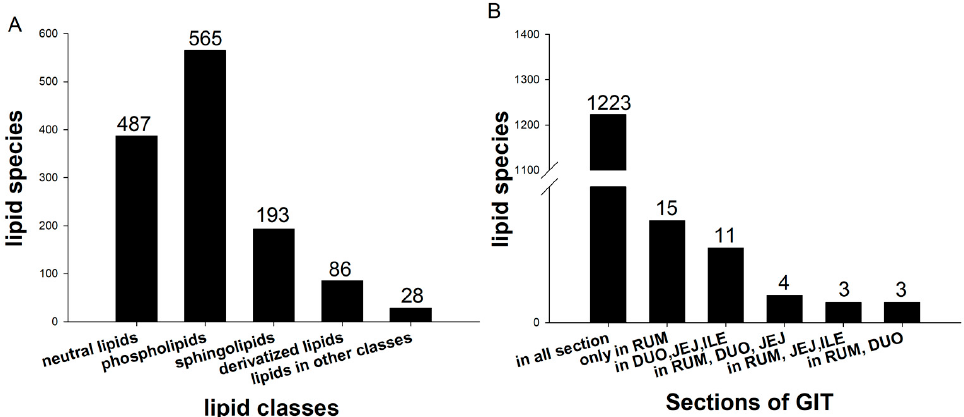
Figure 1. Classification ( A ) and distribution ( B ) of a total of 1259 lipid species identified across the ruminal papillae and epithelium from duodenum, jejunum, and ileum of 5 lactating Holstein cows.